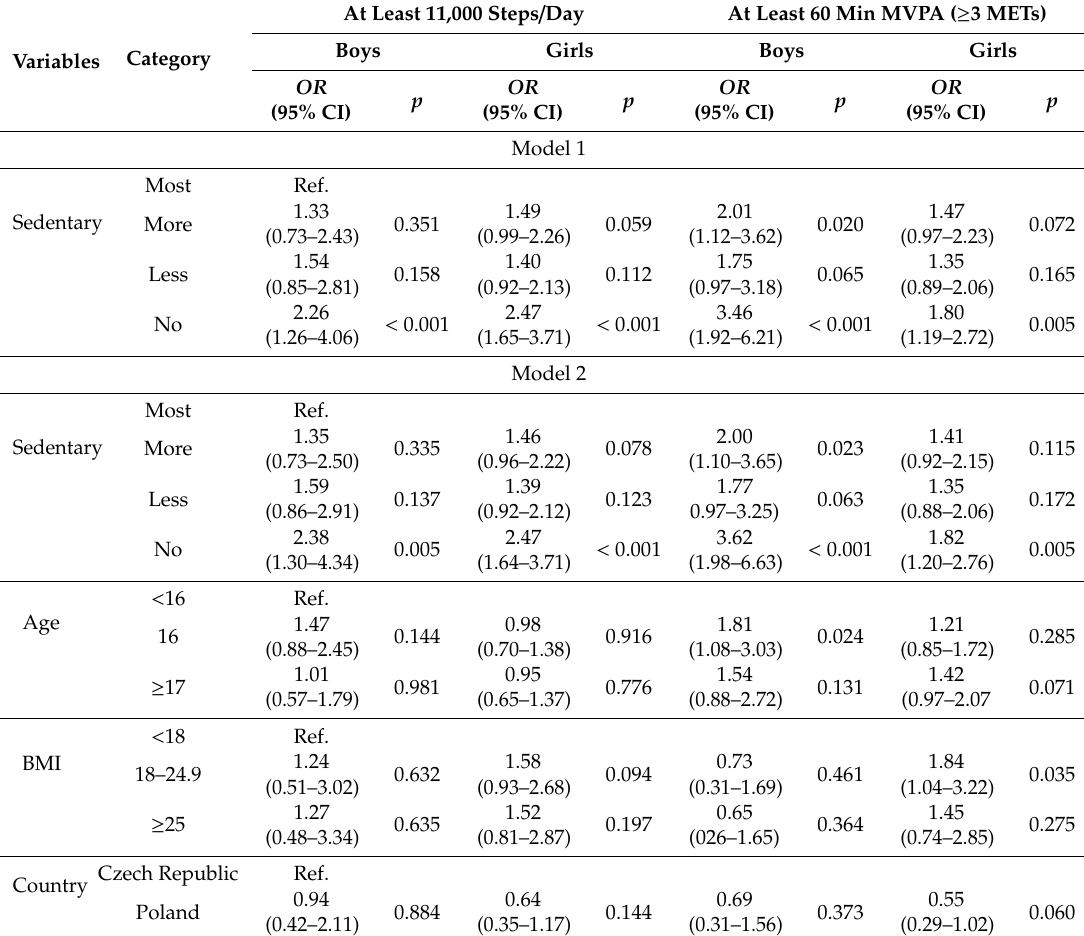
Table 3. The predictors of meeting the PA recommendations (11,000 steps / day and 60 min MVPA) among boys and girls who are non-sedentary and sedentary in